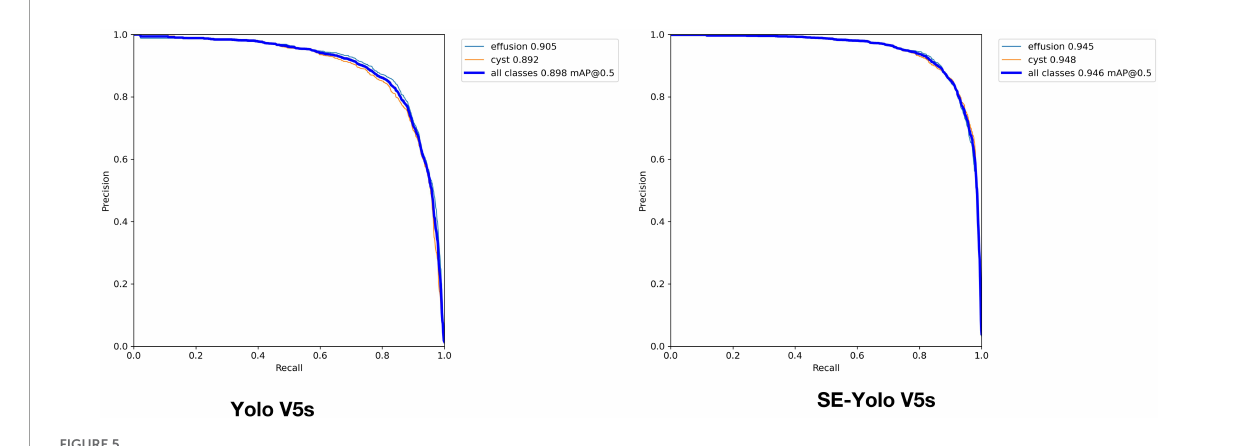
FIGURE5 P-R curves of YOLO V5 and YOLO